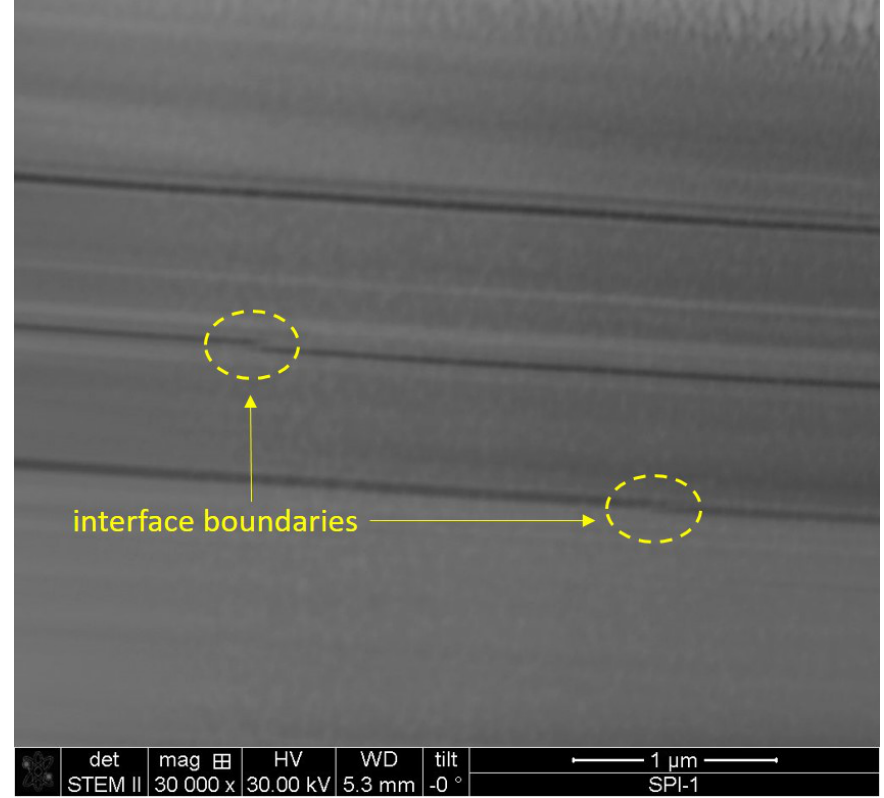
Figure 1. STEM picture of a commercial HOPG (SPI) graphite lamella ( ∼ 400 nm thick) cut from a bulk sample measured also in this work. The electron beam is applied parallel to the graphene layers and normal to the main c -axis of the graphite structure. The different grey colors indicate crystalline regions with different stacking orders (Bernal or rhombohedral) or regions twisted around the c -axis by a certain angle with respect to the neighboring regions. Well-defined two-dimensional interfaces are located between regions with different grey colors at the middle of the picture, which includes also interface boundaries (yellow ellipsoids). More STEM pictures (also with much higher resolution) obtained from different commercial HOPG samples and natural graphite can be seen in [10]; for more details on the samples see Section 5.1 below and Section 3 in the Supplementary